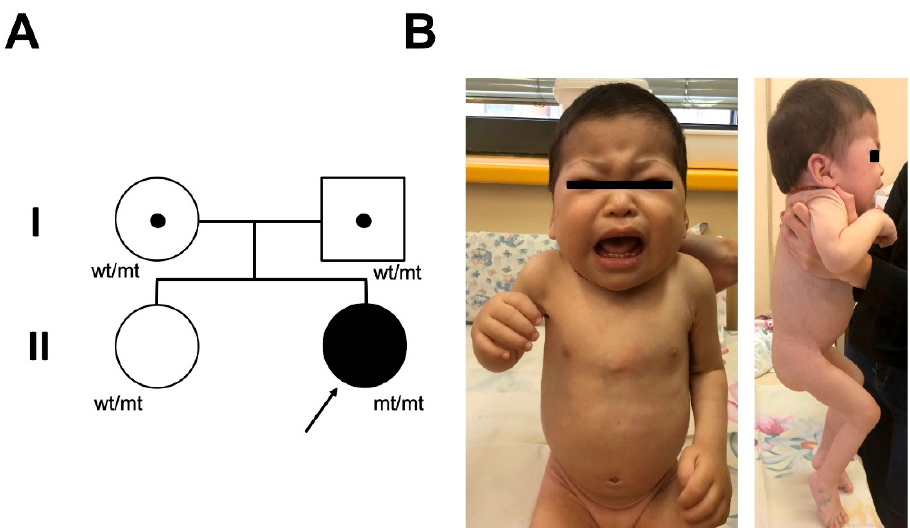
Figure 5. Pedigree of the family and clinical phenotype of the patient. ( A ) Pedigree of the probands family. wt, wild-type allele; mt, mutant allele, c.1492C>T, p.R498W in VPS33A . ( B ) Clinical phenotype of patient at age of one-year nine-month. Coarse facial features, periorbital puffiness, thick skin, short neck, deformation of the chest wall, contractures at the fingers, elbow and knee. Informed consent with permission to publish patient photos and case details was obtained from parents.